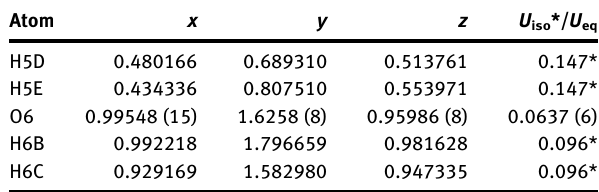
Table  : Fractional atomic coordinates and isotropic or equivalent isotropic displacement parameters (Å 